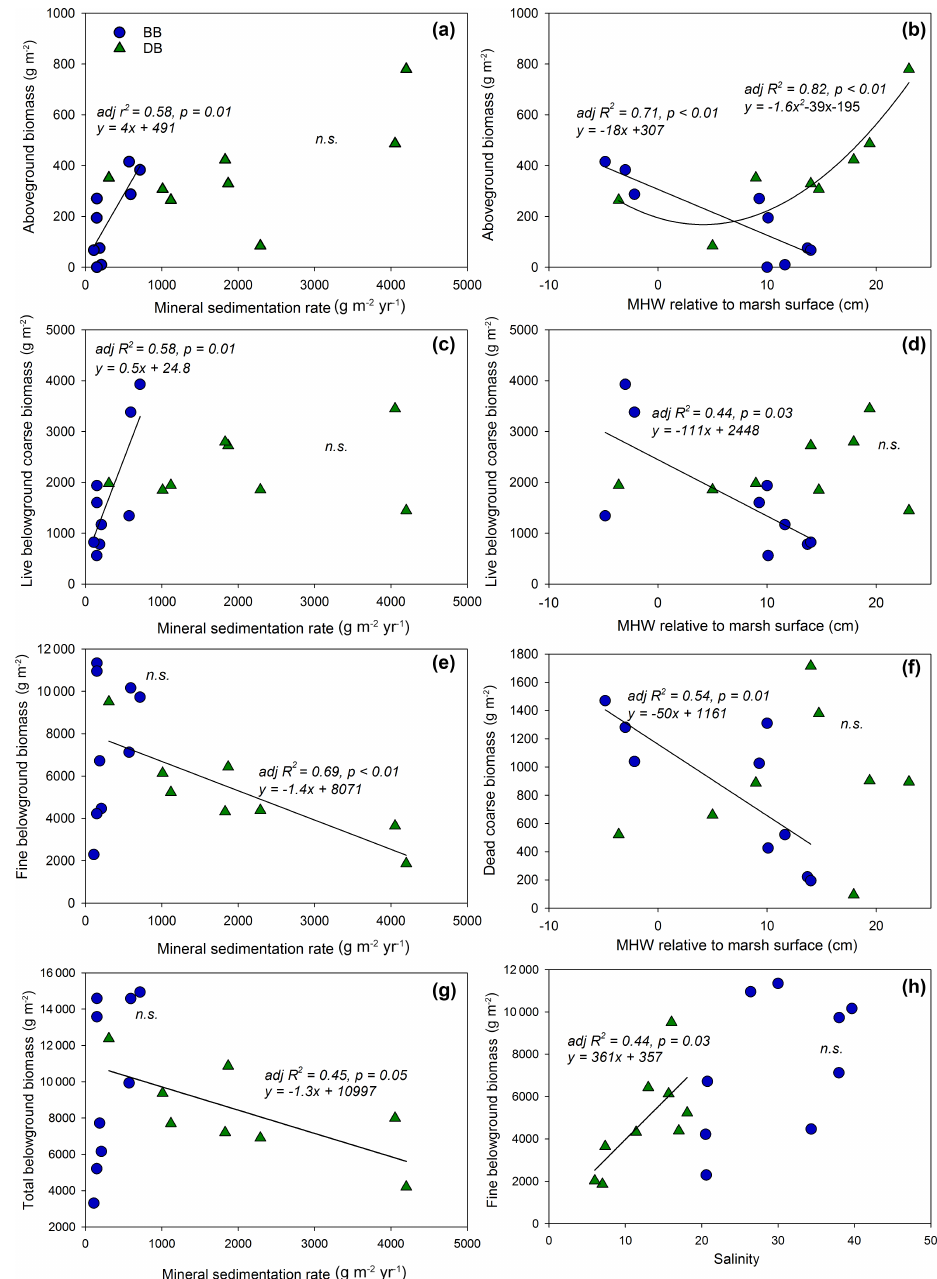
Figure 4. Relationships between vegetation structure and environmental parameters. For these analyses, belowground biomass to 50cm depth was used. Mineral sedimentation rates were calculated using 137 Cs dating and, therefore, are average rates over the last 50 years (Boyd et al., 2017). Blue dots and green triangles refer to data collected in Barnegat Bay (BB) and Delaware Bay (DB), respectively, which were analyzed separately. Both significant and nonsignificant (n.s.) relationships are